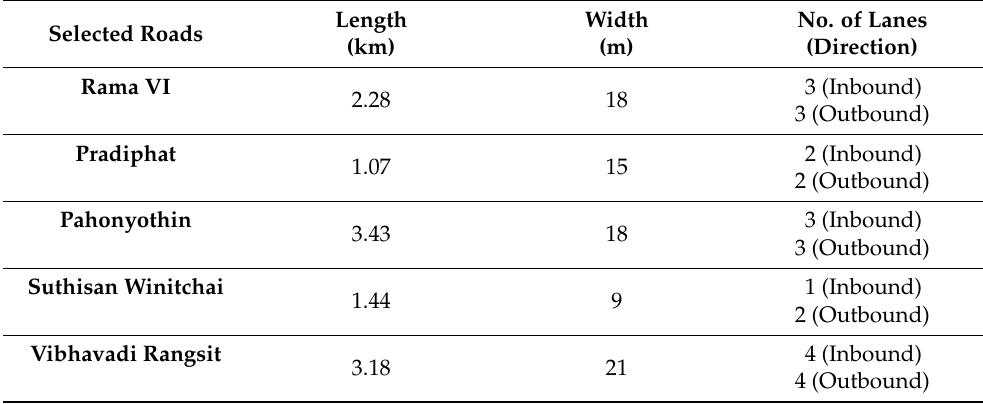
Table 1. Five roads selected to collect data on traffic density and fleet composition. Length Selected Roads